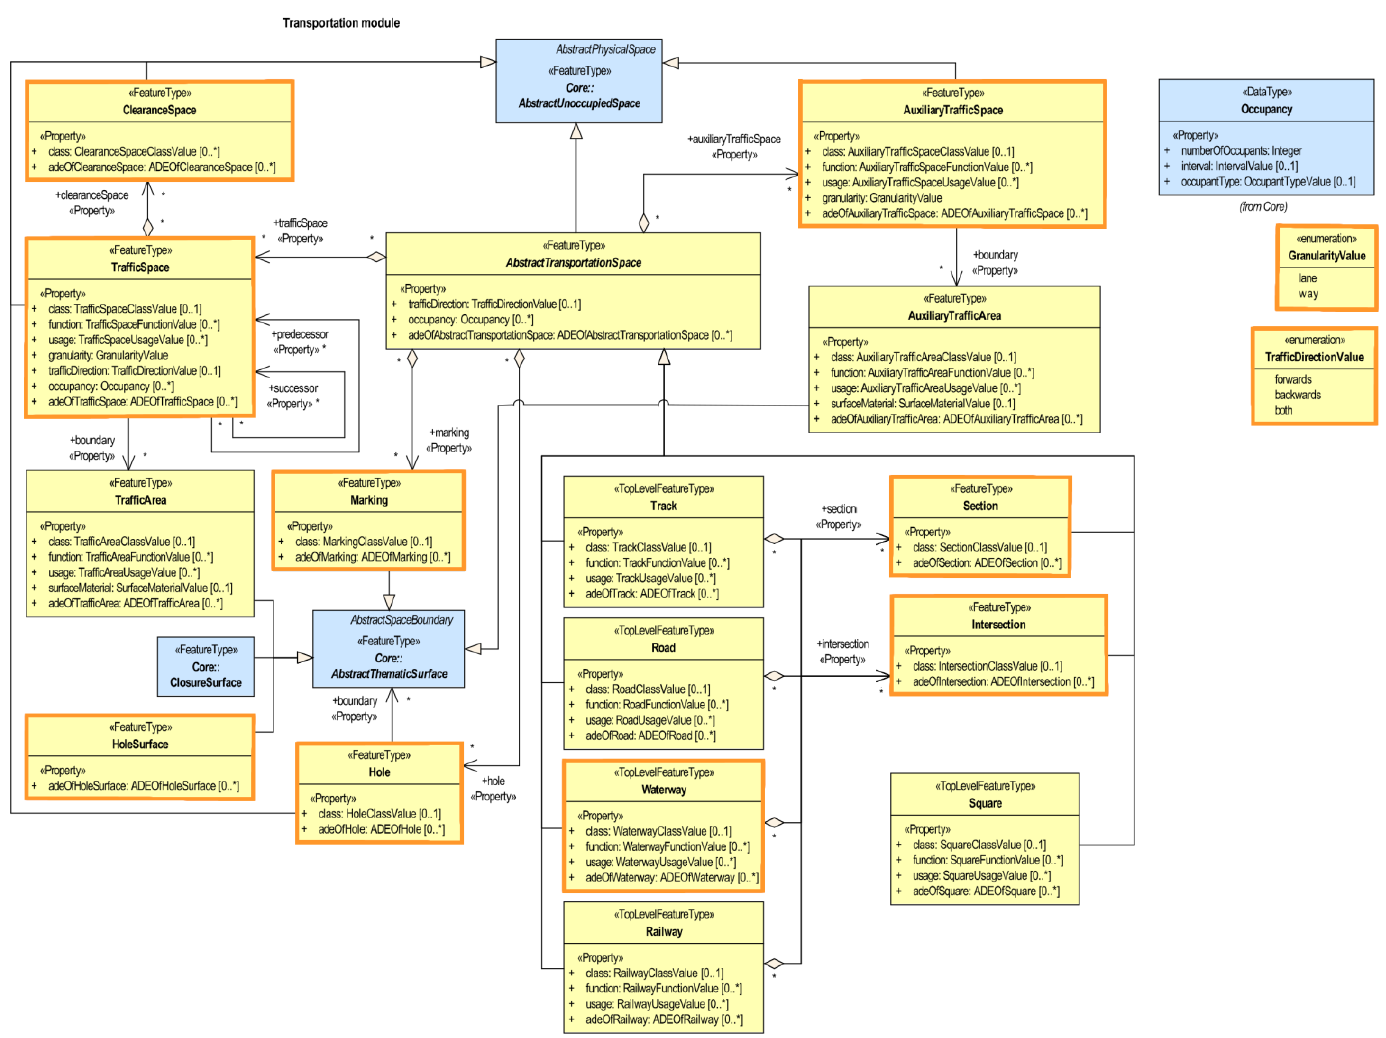
Figure 2. CityGML 3.0 Transportation Model as presented by the OGC CityGML SWG [69]. New classes compared to CityGML2.0 are marked with orange borders.